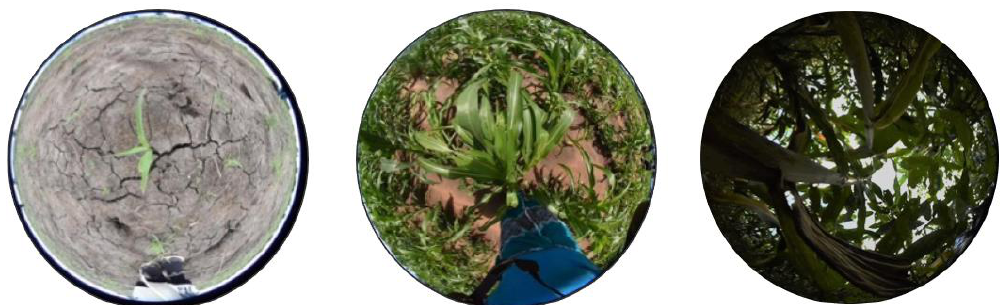
Figure 2. Example DHP images of maize fields capturing different growth stages in the Phalombe district. Images were taken on the following dates (from left to right ): 23 December 2019 (seeding), 11 January 2020 (vegetative), and 23 February 2020 (grain-filling) to capture maize main growth stages.